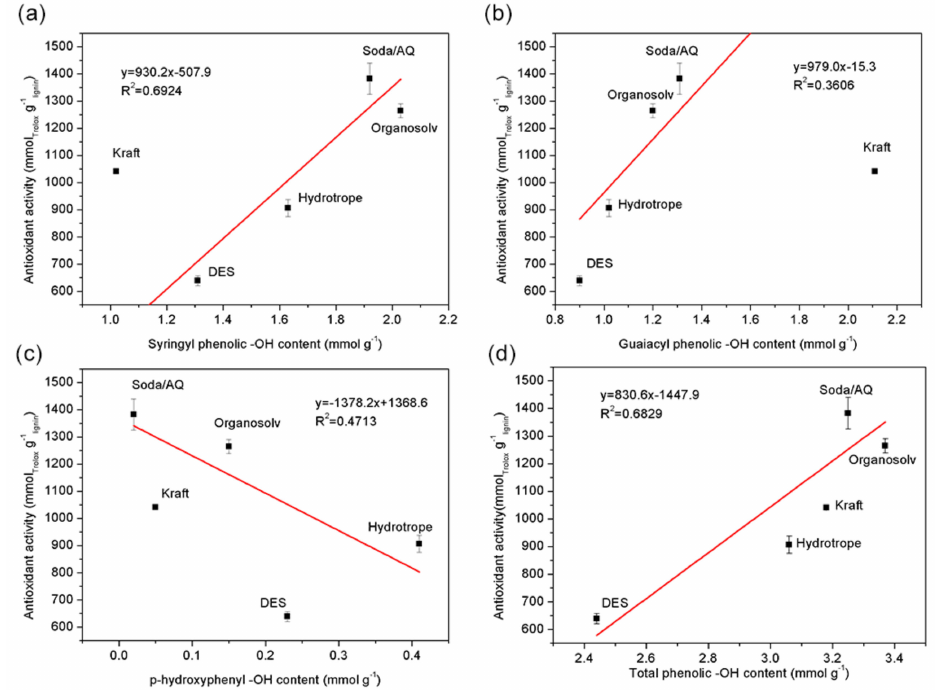
Figure 3. Relationship among antioxidant activity and the content of ( a ) syringyl phenolic hydroxyl groups, ( b ) guaiacyl phenolic hydroxyl groups, ( c ) p-hydroxyphenyl phenolic hydroxyl groups and ( d ) total phenolic hydroxyl groups of those five